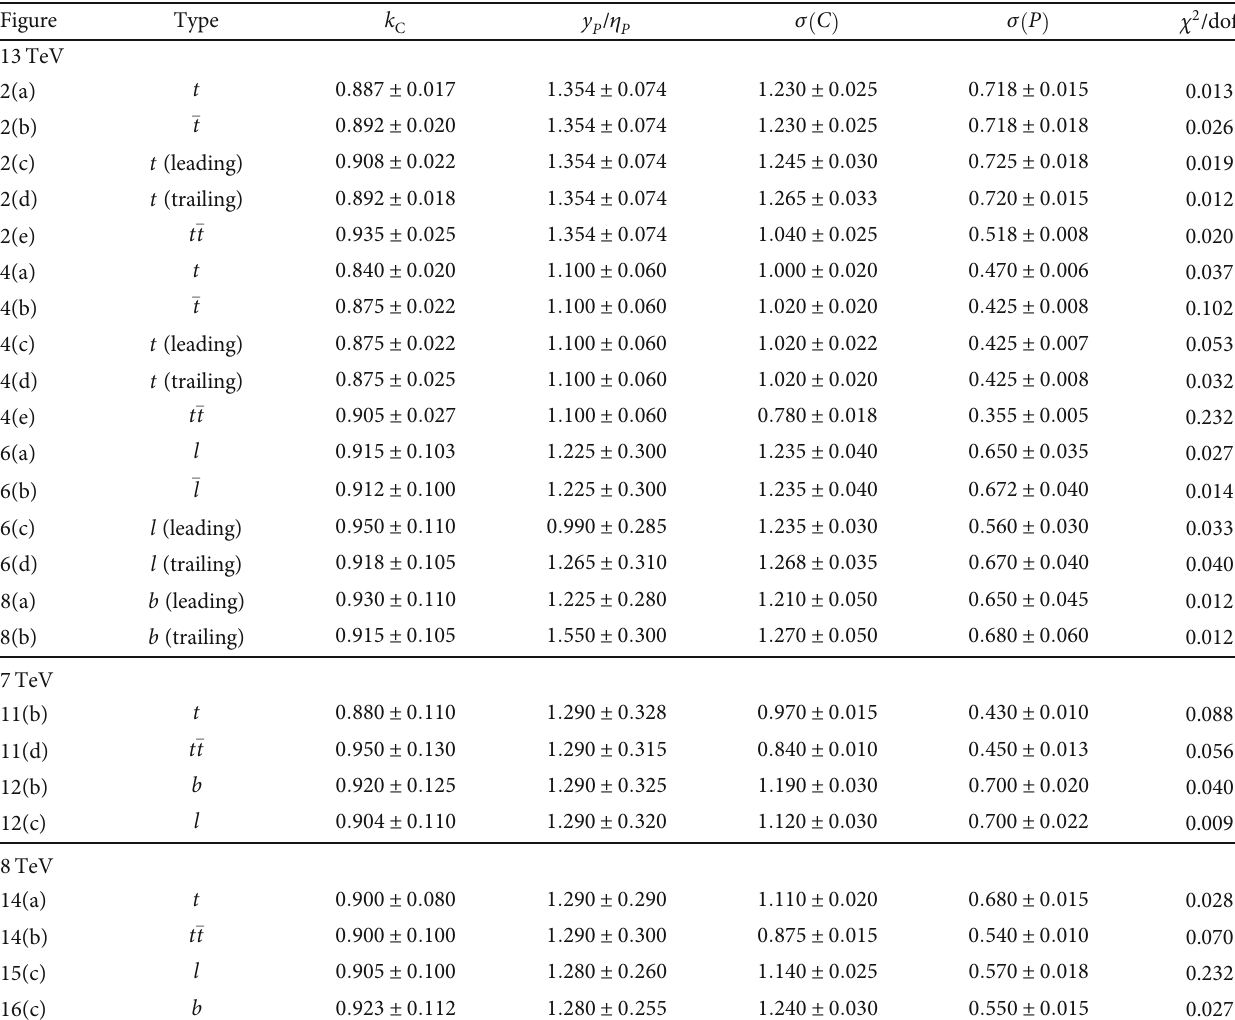
Table 2: Values of parameters and χ 2 /dof corresponding to the curves in Figures 2, 4, 6, 8, 11, 12, 14, 15, and 16.